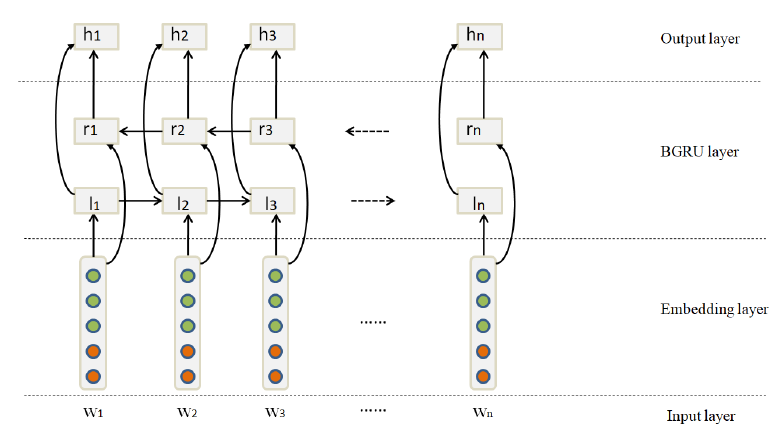
Figure 6. The architecture of the bidirectional